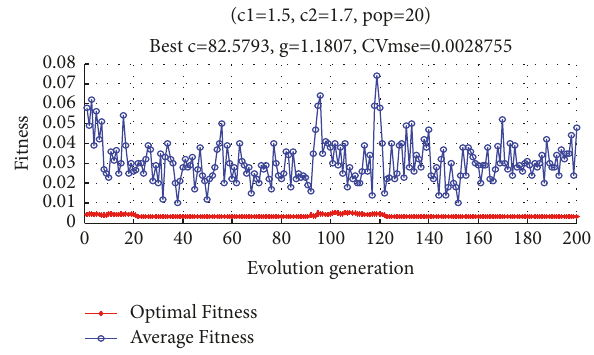
Figure 3: Optimal parameter results of PSO.